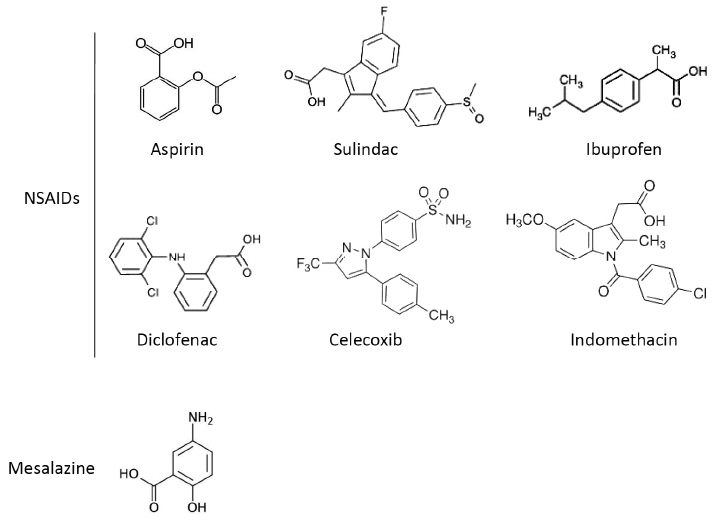
Figure 1. Chemical structures of common non-steroidal anti-inflammatory drugs (NSAIDs) and